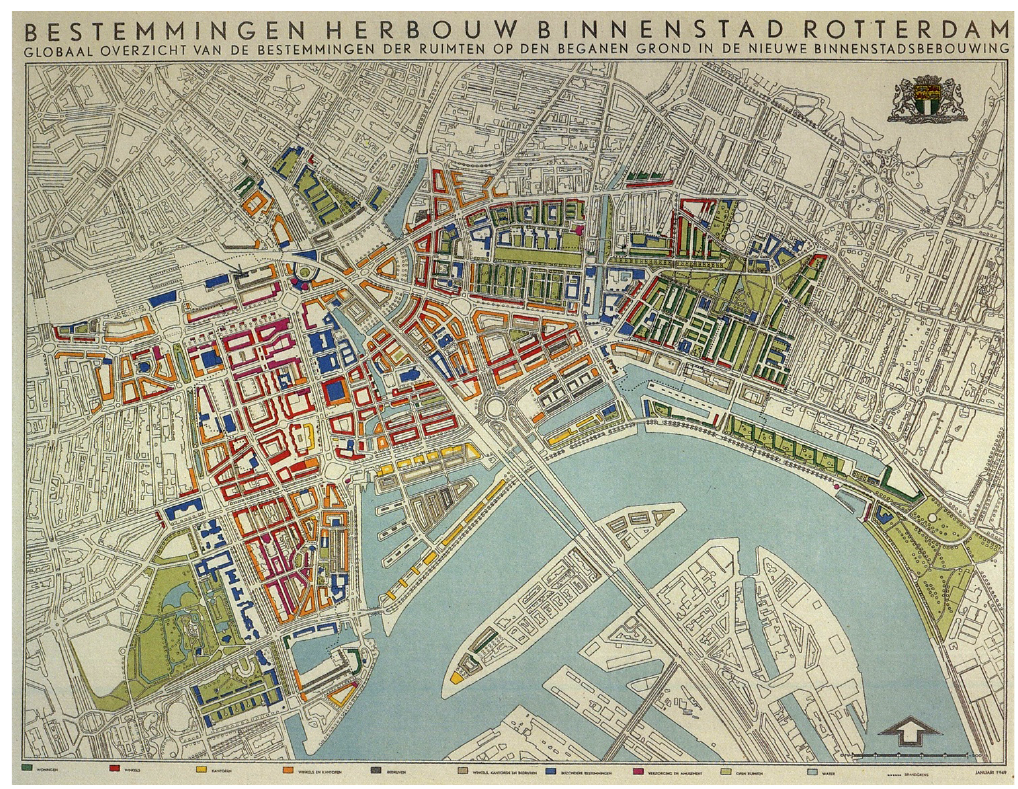
Figure 8. Bestemmingen herbouw Binnenstad Rotterdam, by Van Traa in 1946. Source: Van de Laar and van Jaarsveld (2004, p. 60).